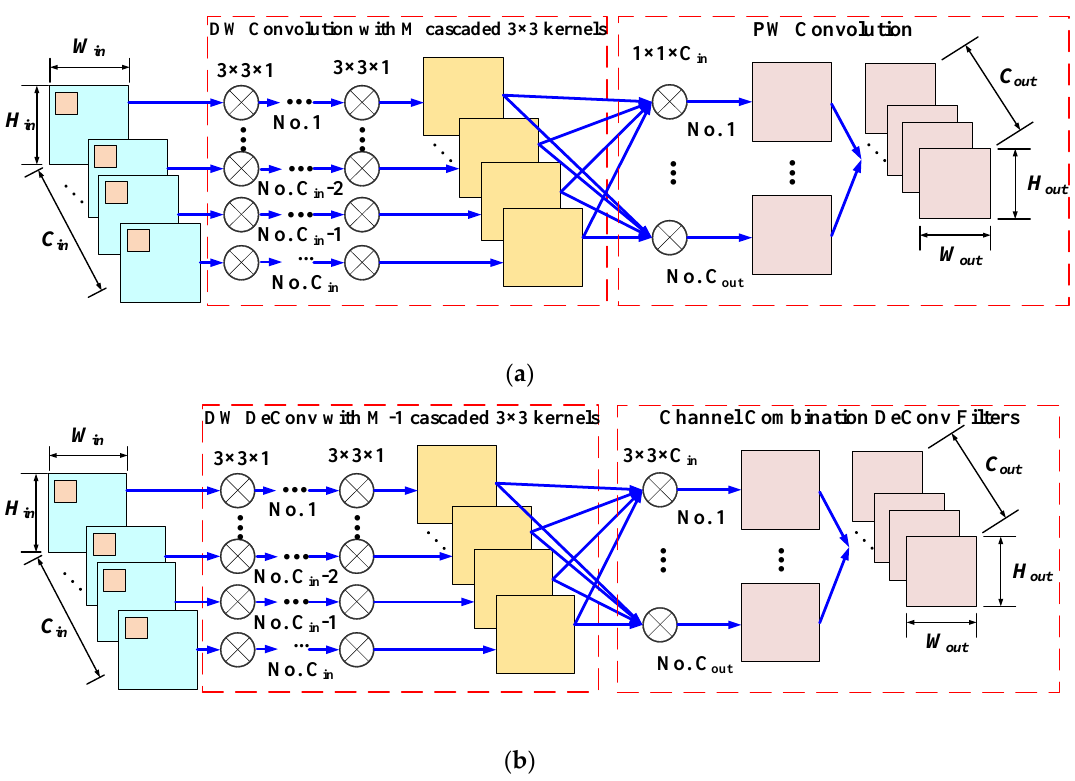
Figure 5. The proposed compact depth-wise separable convolution (CSeConv) and the corresponding compact separable deconvolution (CSeDeConv)layer which combines the depth-wise (DW) separable convolution/deconvolution scheme and the kernel decomposition scheme to reduce the trainable parameters. ( a ) The procedure of the CSeConv layer; ( b ) the details of the CSeDeConv. The size of the input feature map and output feature map in ( a ) and ( b ) are W in × H in × C in and W out × H out × C out ,